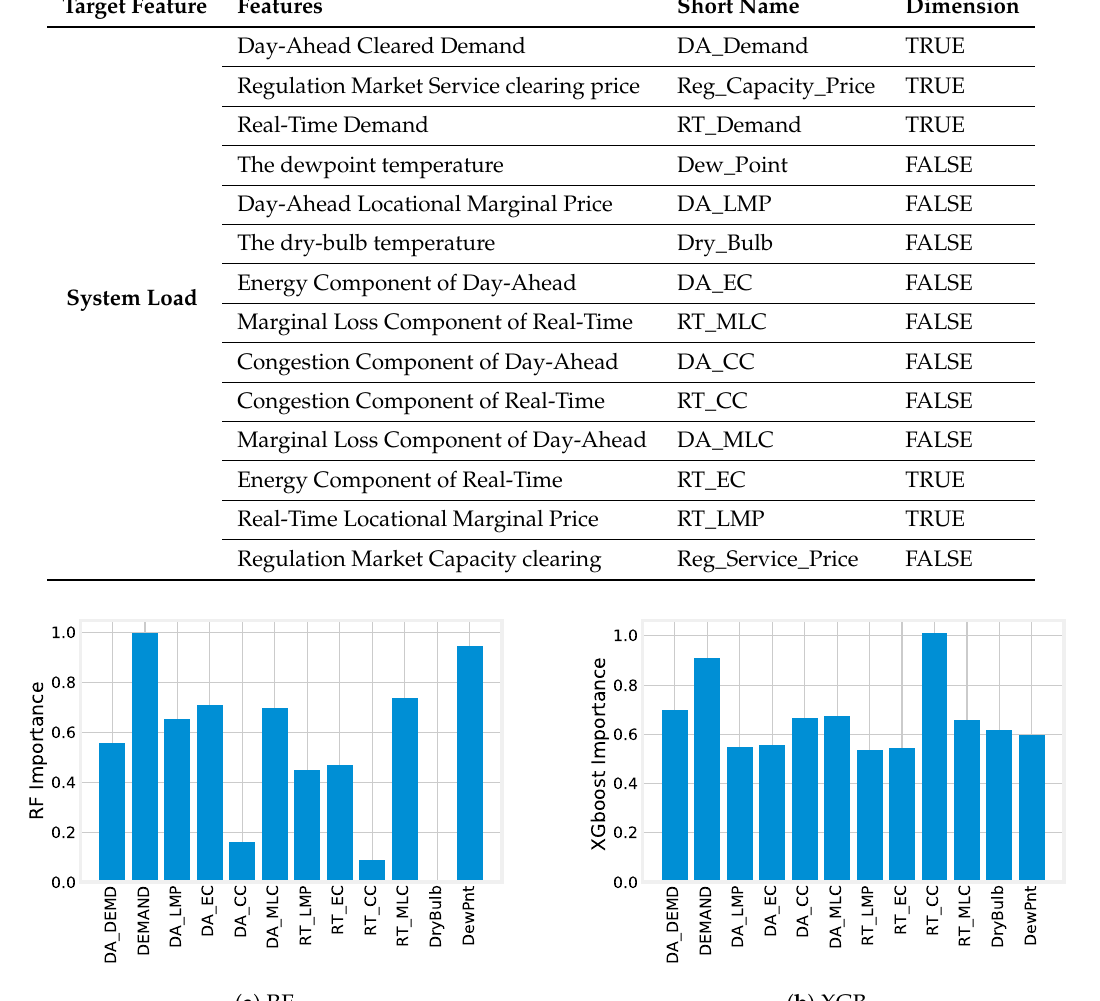
Table 2. Features overview and dimensions calculated by Recursive Feature Elimination (RFE).